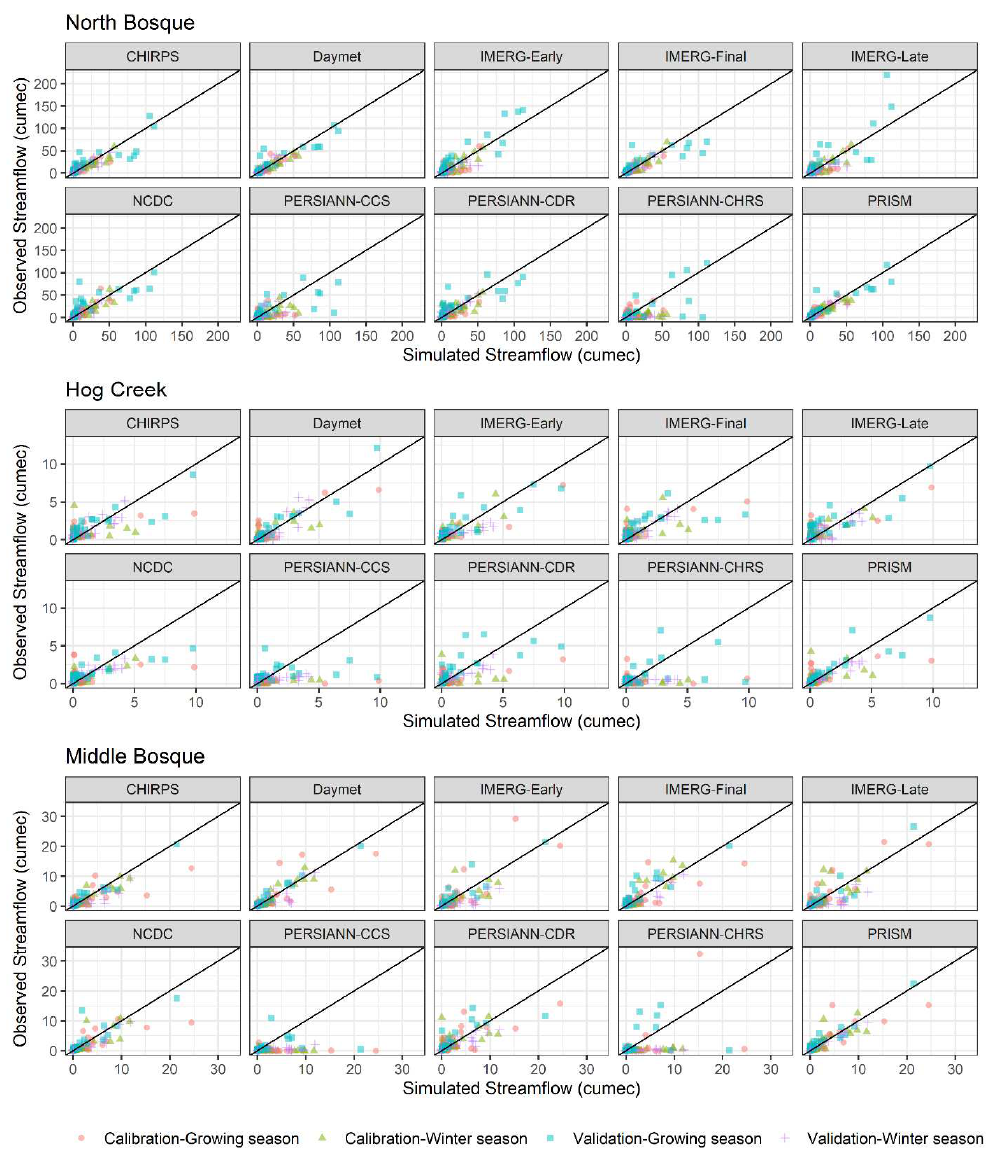
Figure 7. Observed and simulated monthly streamflow data (2001–2019) with different precipitation datasets in three sub-basins of the Bosque watershed.